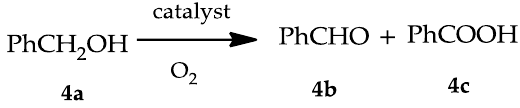
Figure 4. Oxidation of benzyl alcohol ( 4a ) into benzaldehyde ( 4b ) and benzoic acid ( 4c ). Table 1. Oxidation of benzyl alcohol ( 4a ) with molecular oxygen using Au/calc-Sr sup and Au/Sr sup catalysts 1 .